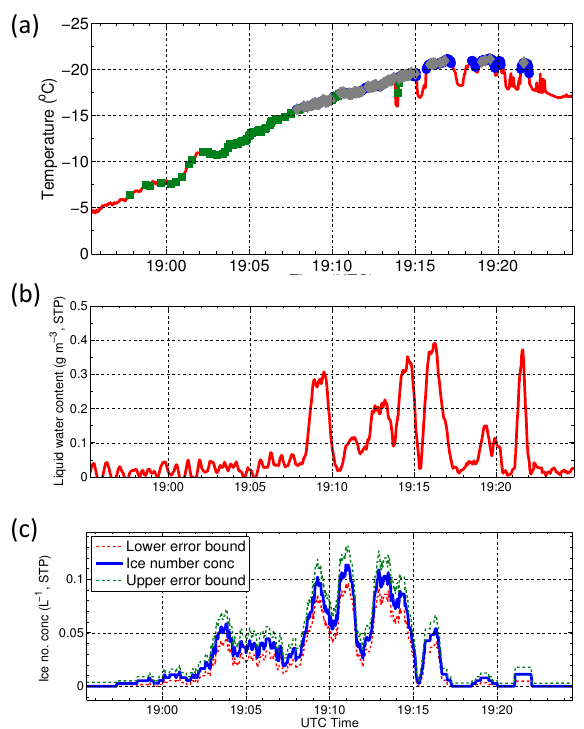
Fig. 5. Measurements made during flight #104 as the aircraft as- cended over the Antarctic Peninsula ridge. (a) – Temperature; (b) – 30s moving mean window liquid water content from the hotwire probe; (c) – 60s moving window mean ice number concentrations with lower and upper Poisson error bounds. The symbols in (a) show: ice only regions (green); water only (blue) and mixed phase regions (grey), as in Fig.